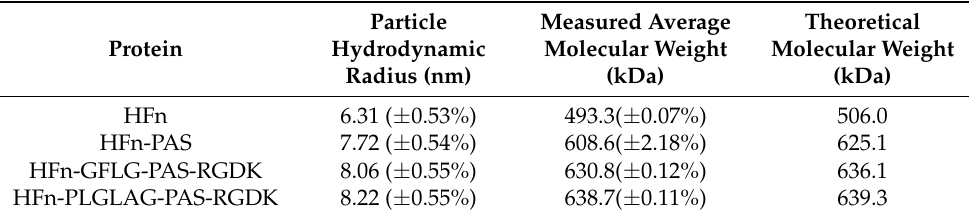
Table 1. Hydrodynamic radius and molecular weight determined by HPSEC-MALLS.